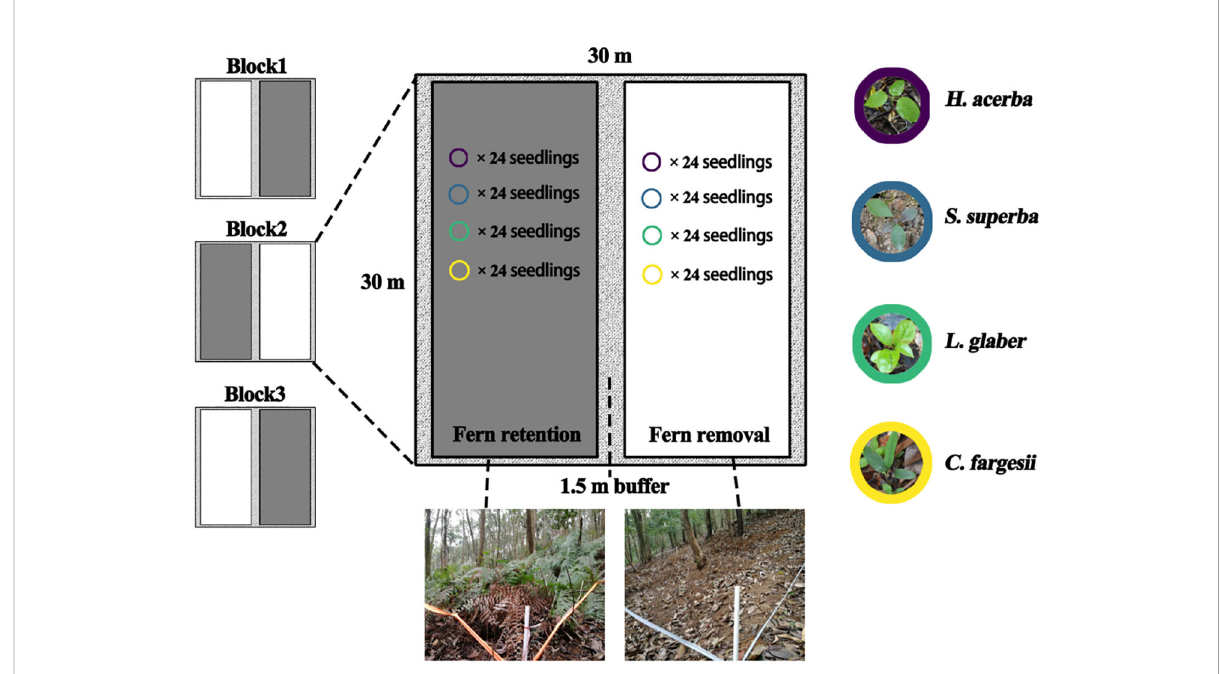
FIGURE 1 Layout of the treatments of the understory fern